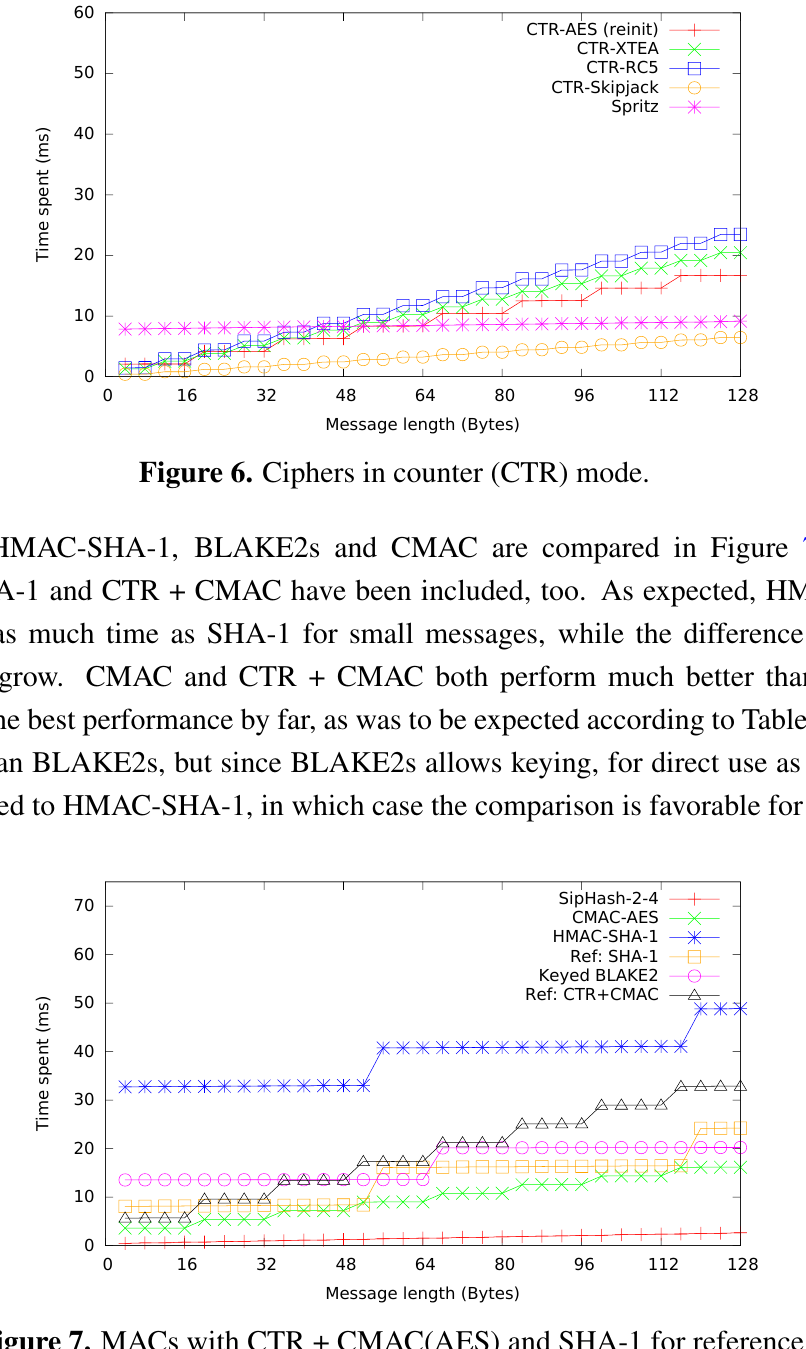
Figure 7. MACs with CTR + CMAC(AES) and SHA-1 for